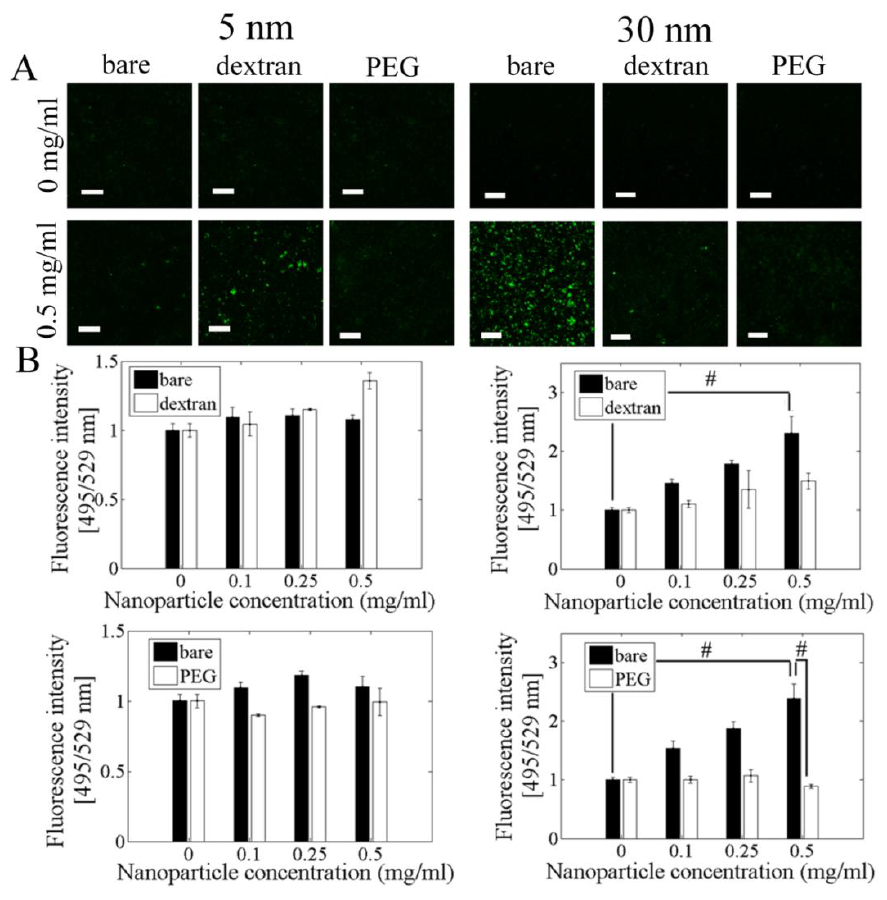
Figure 4. Bare 30 nm nanoparticles induced the highest level of intracellular ROS formation. ( A ) Selected confocal microscopy ROS images. PAEC were incubated with different concentrations of bare and coated nanoparticles for 3 h. Cells were then labeled with 10 μM carboxy-H DCFDA (green), a general ROS indicator. Scale bar = 100 µm; 2 ( B ) Quantification of ROS formation by Image J. # p <